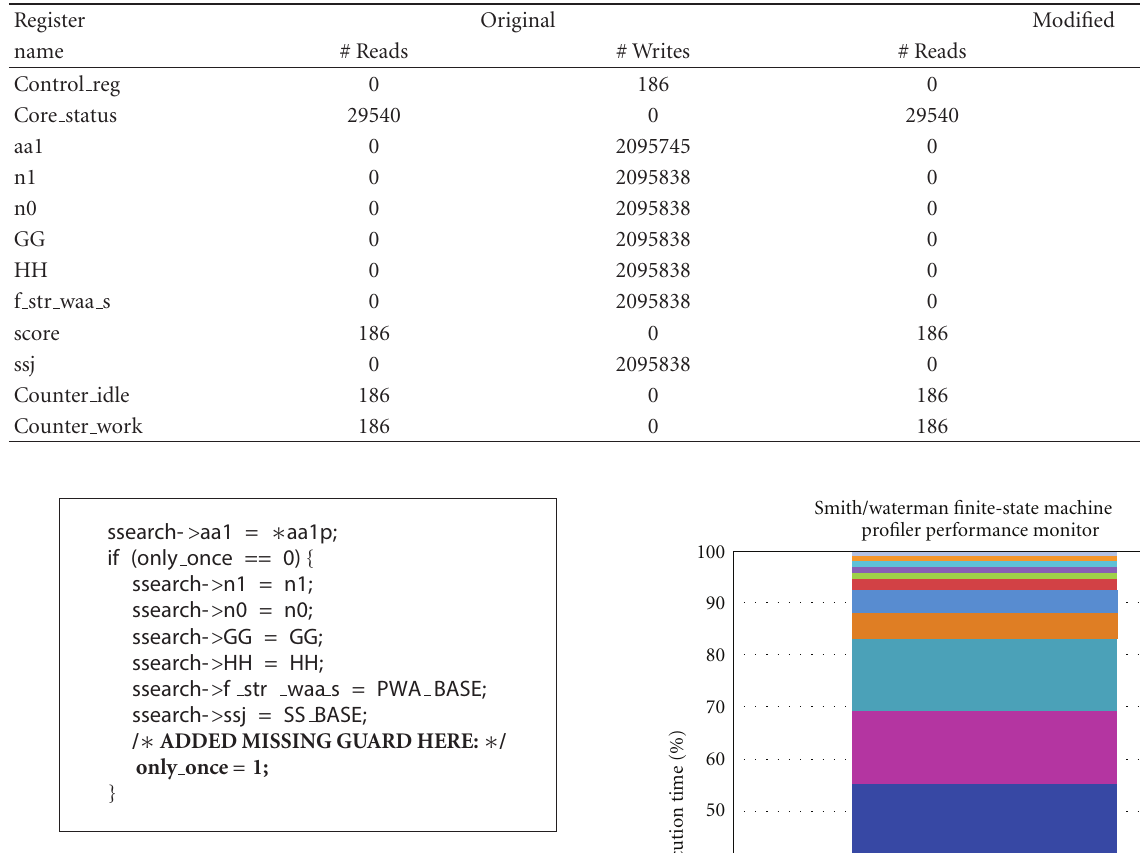
Figure 11: Modification made to original dropgsw2.c.